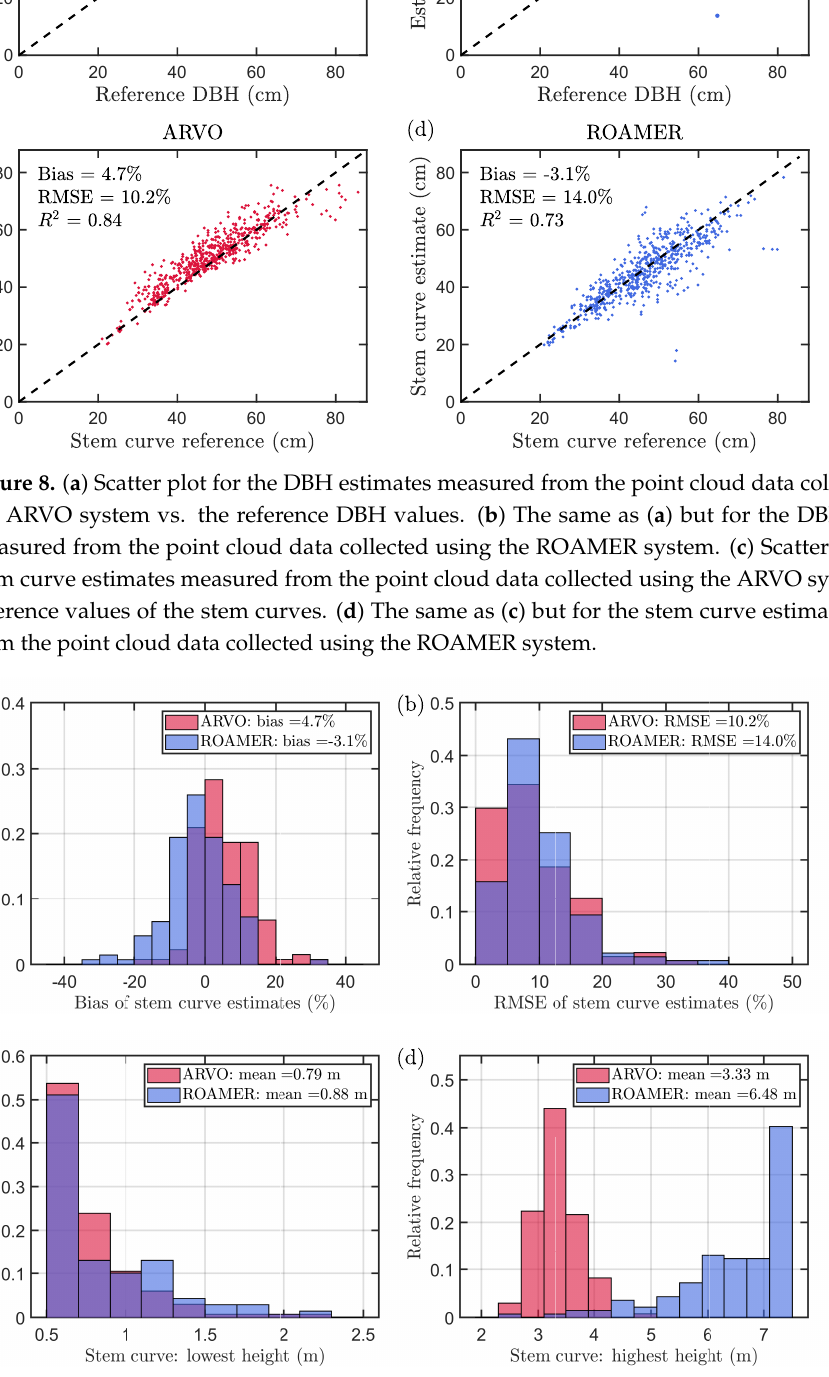
Figure 9. ( a ) Histogram for the relative bias values of the measured stem curves based on Equation (11). ( b ) Histogram for the relative RMSE values of the measured stem curves based on Equation (12). In panels ( a , b ), we removed a single outlying stem curve measurement (bias = − 70.4%, RMSE =